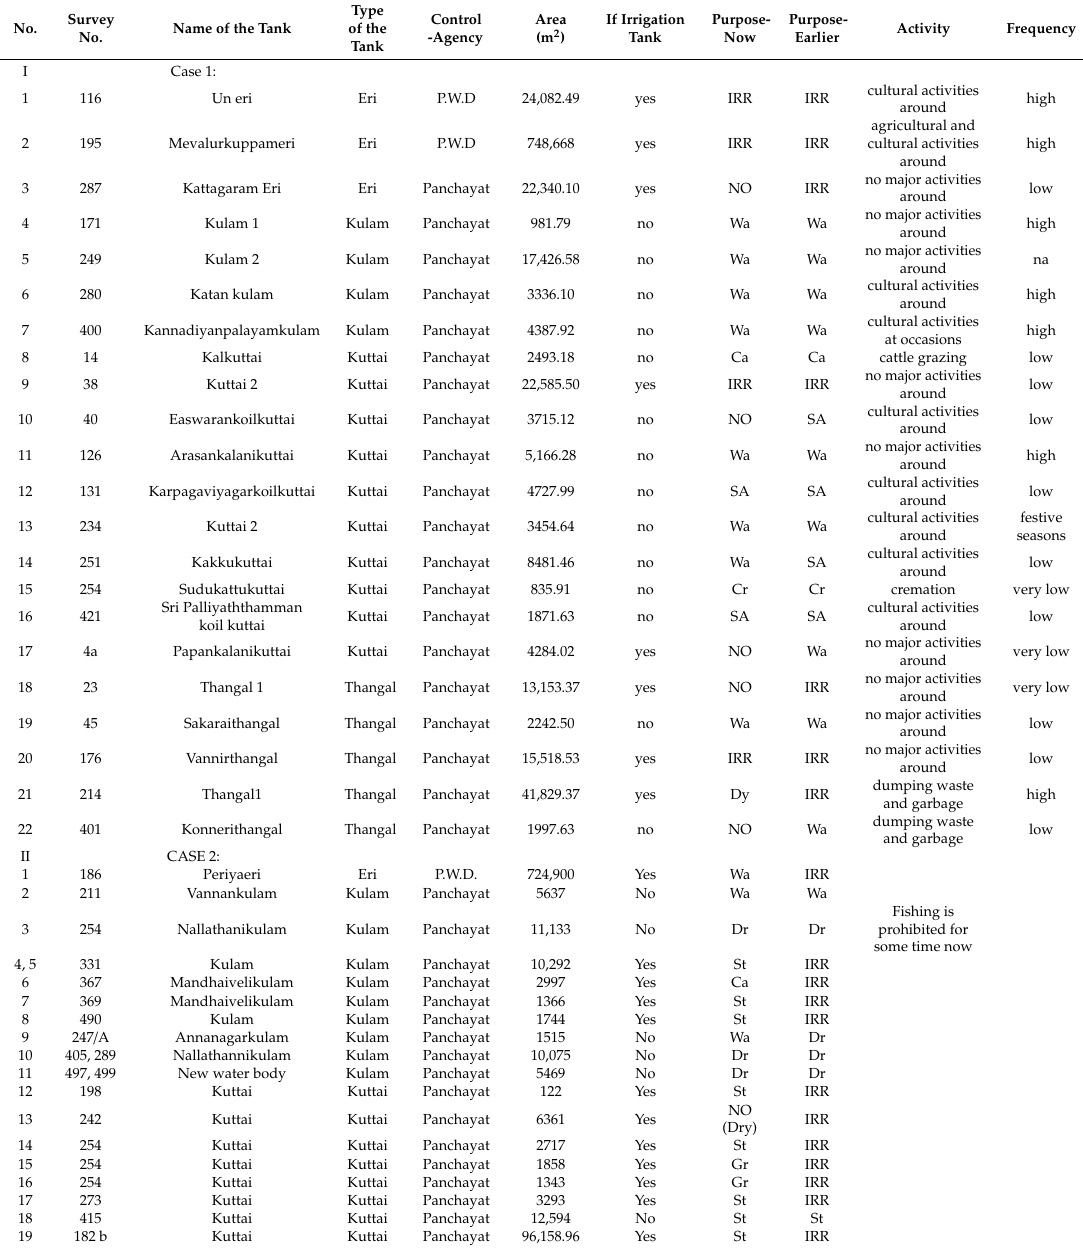
Table A3. Consolidated data from the interview for all the tanks in both